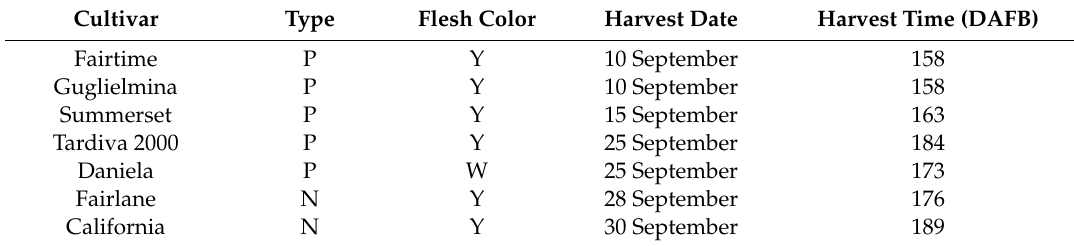
Table 1. Fruit type, flesh color, harvest date, and harvest time in days after full bloom (DAFB) of the seven cultivars grown (500 trees / ha) near Riesi (37 ◦ 16 (cid:48) N and 330 m a.s.l.), in central–southern Sicily. P, peach; N, nectarine; Y, yellow flesh; W, white flesh.